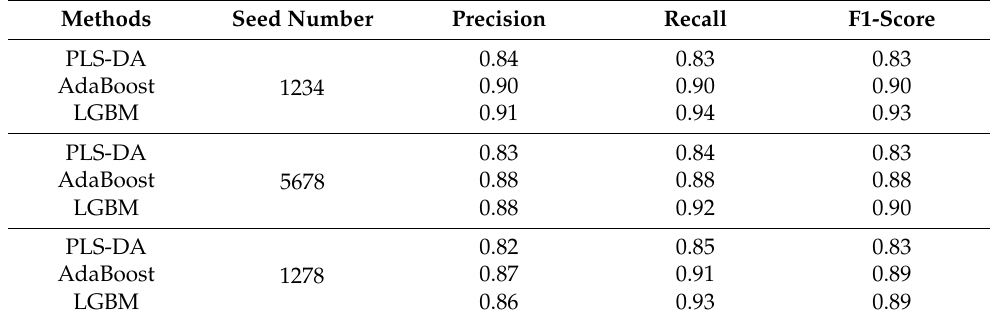
Table 3. The precision, recall, and F1-score values of the established models for hERG properties.